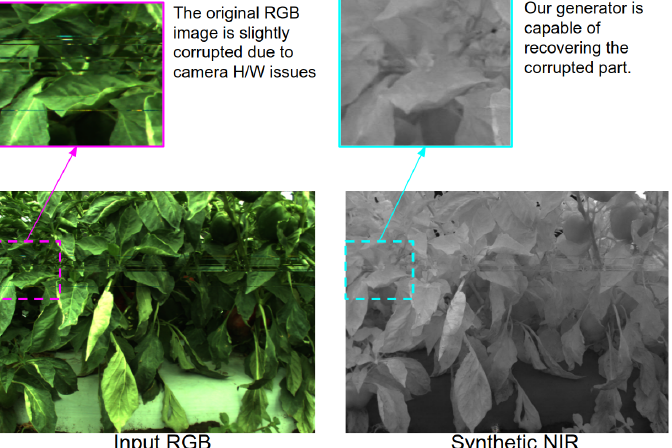
Figure 15. This figure illustrates in-painting capabilities of our generator. The left image shows data corruption due to hardware issue and the right depicts recovered region of interest (cyan) in synthetic NIR